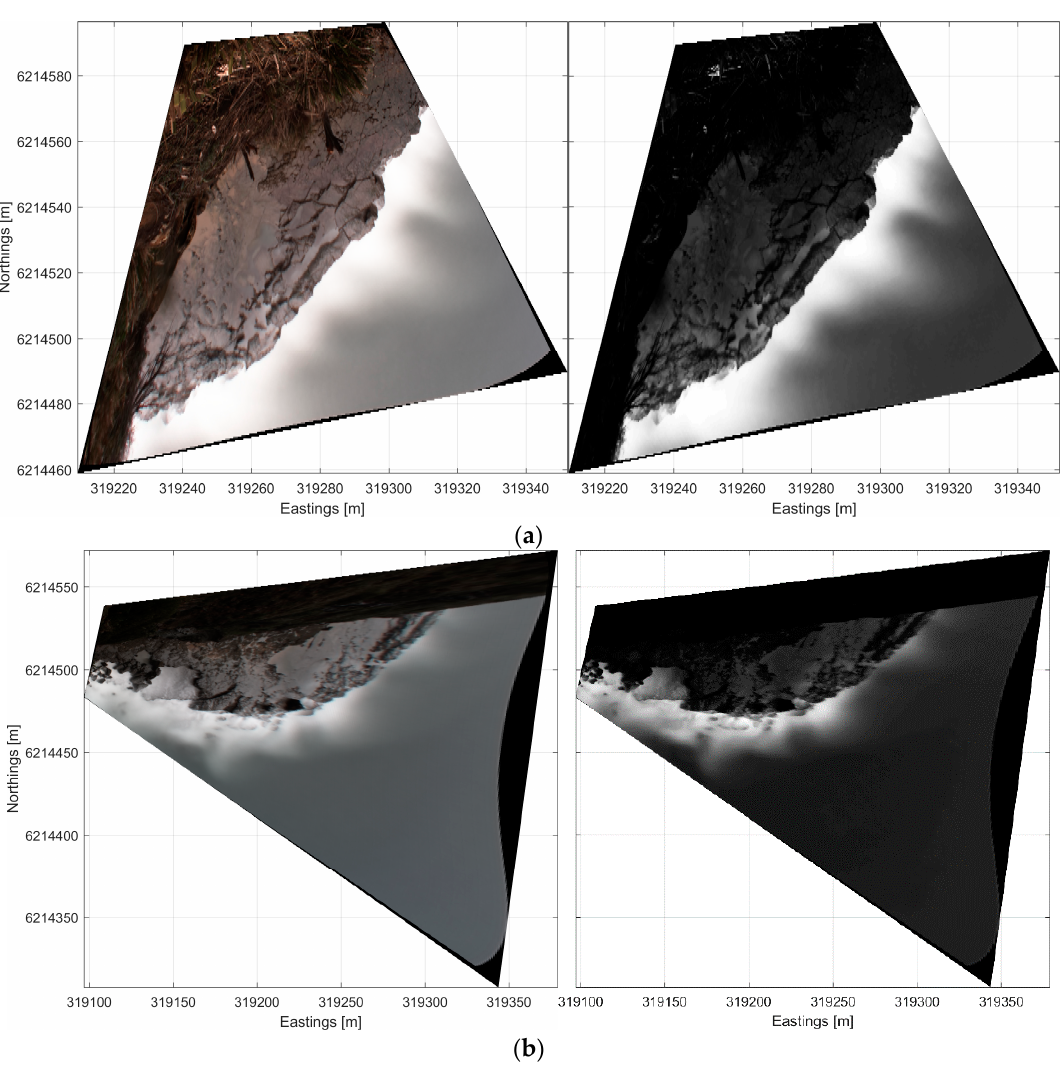
Figure 7. Example timex (left panels) and variance (right panels) images created from the camera data for ( a ) the north camera and ( b ) the south camera 12:00 on 23/03/2017. Eastings and northings correspond to the coordinate system GDA94 MGA Zone 56.